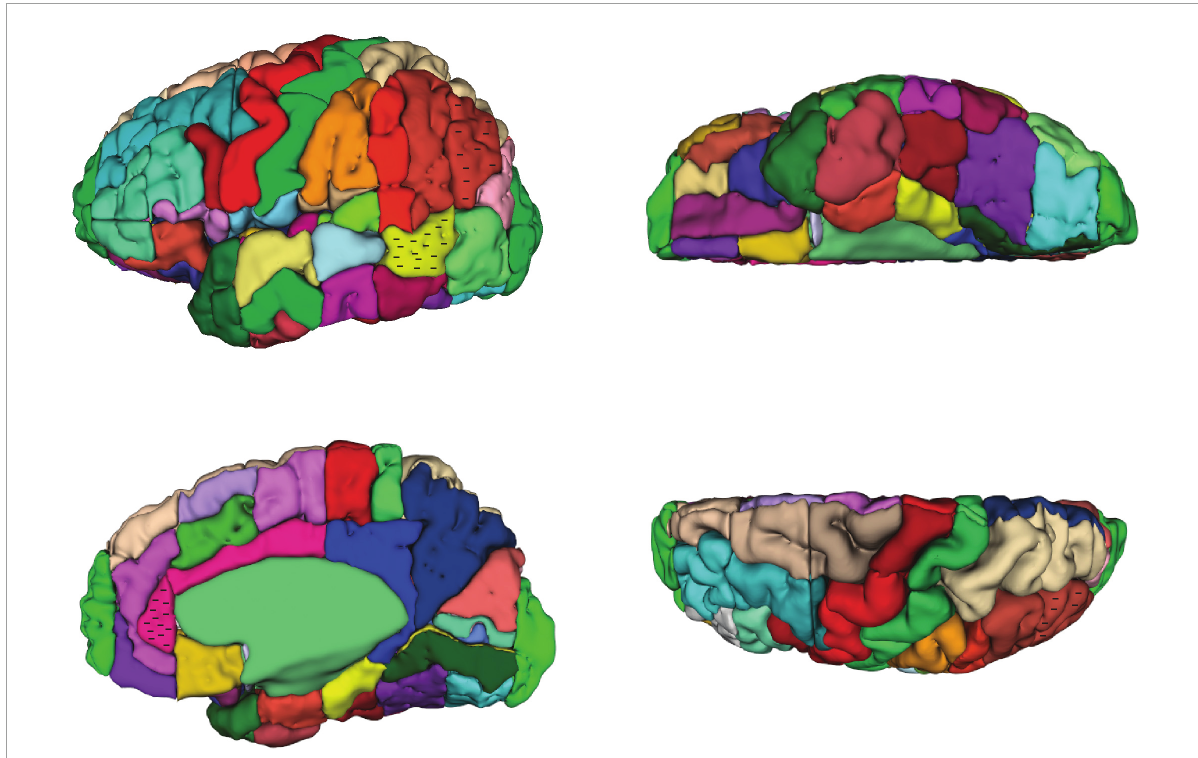
FIGURE2 Three-dimensional representation of the revised Harvard-Oxford Atlas parcellation of the human brain, hHOA2.0. Refer to Figure 1 for parcellation unit (PU) identity.